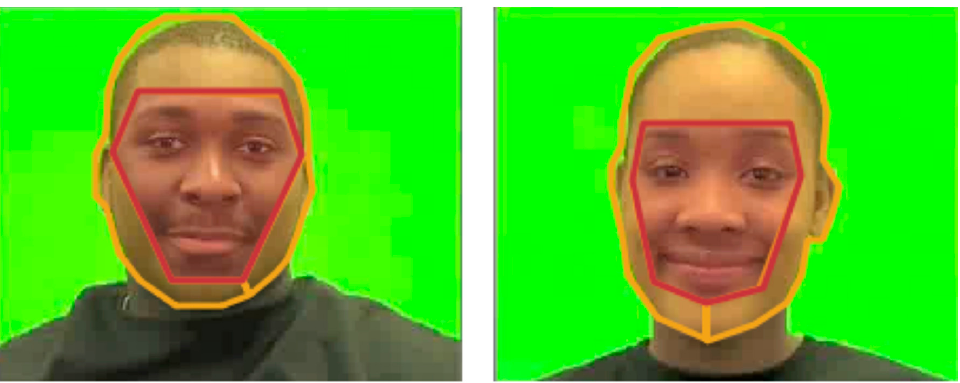
Figure 2. Examples of the internal and external areas-of-interest (AOIs) for two of the faces in the pleasant condition. Note that the AOIs were uniquely adapted to account for movement in the face while the models spoke.